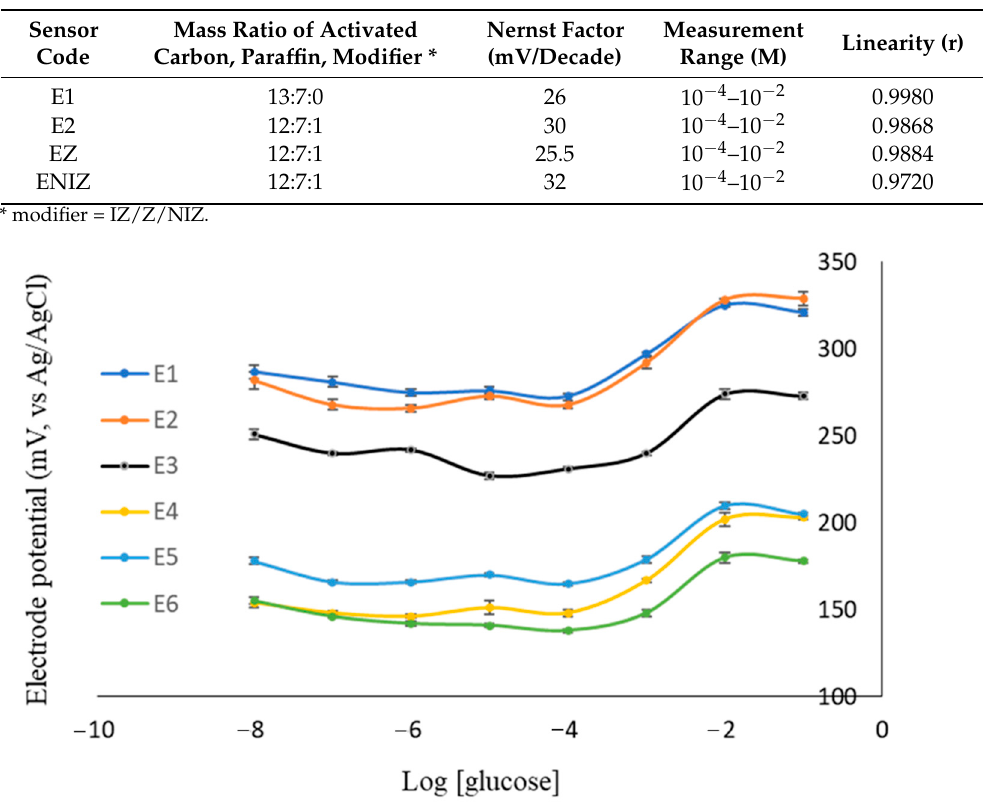
Figure 8. The correlation of electrode potential toward log [glucose] in the various compositions of the electrode. the